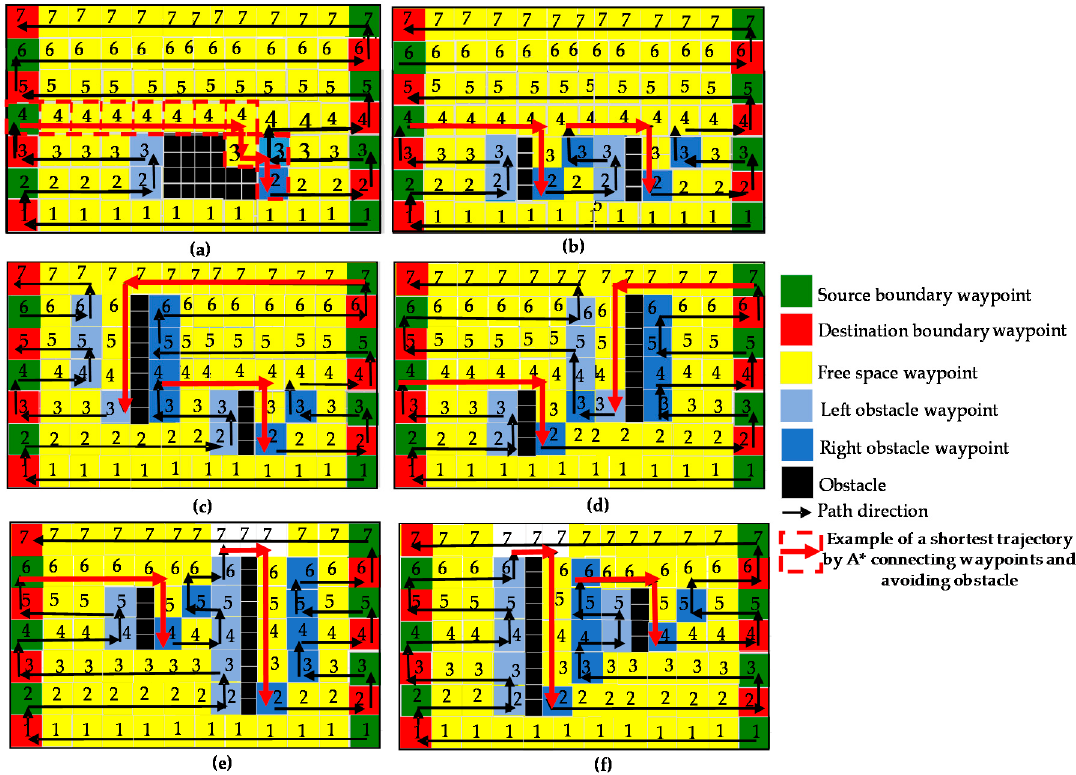
Figure 12. Proposed zigzag scanning method. ( a ) the single obstacle, ( b ) obstacles with the same size and locate on same lines, ( c – f ) obstacles with different sizes and locate on different lines between left and right boundary waypoints.